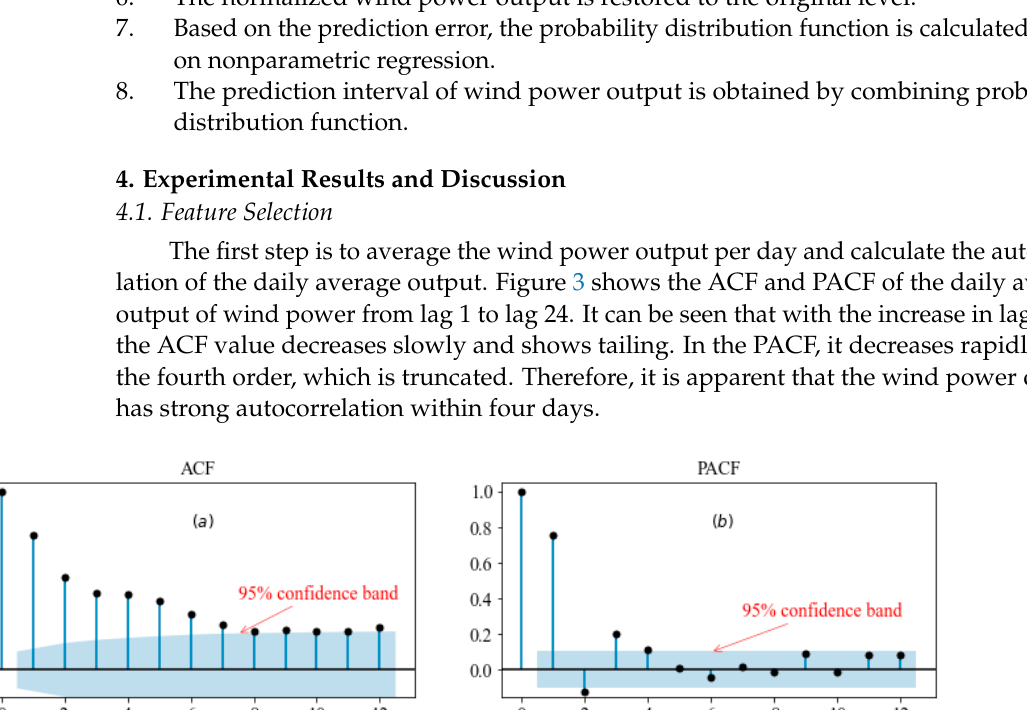
as shown in Table 2.